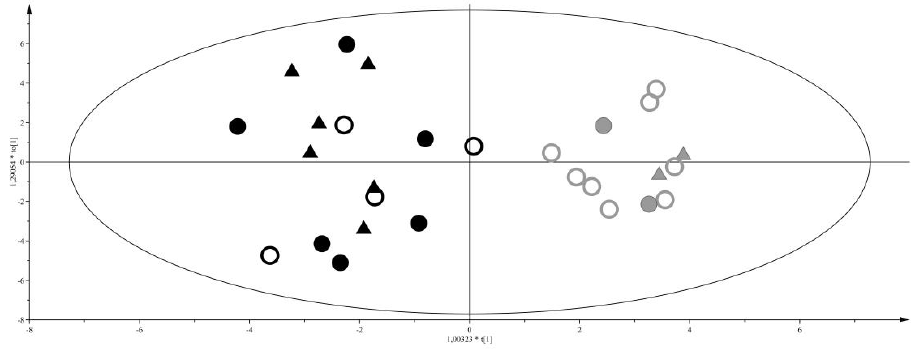
Figure 5. OPLS-DA of BM vs. FM neonates at T3, R 2 Y = 0.88 and Q 2 Y = 0.61. Score plot, triangles represent the AGA class, filled and empty circles LGA and IUGR, respectively. Black and grey colours represent BM and FM feeding, respectively.